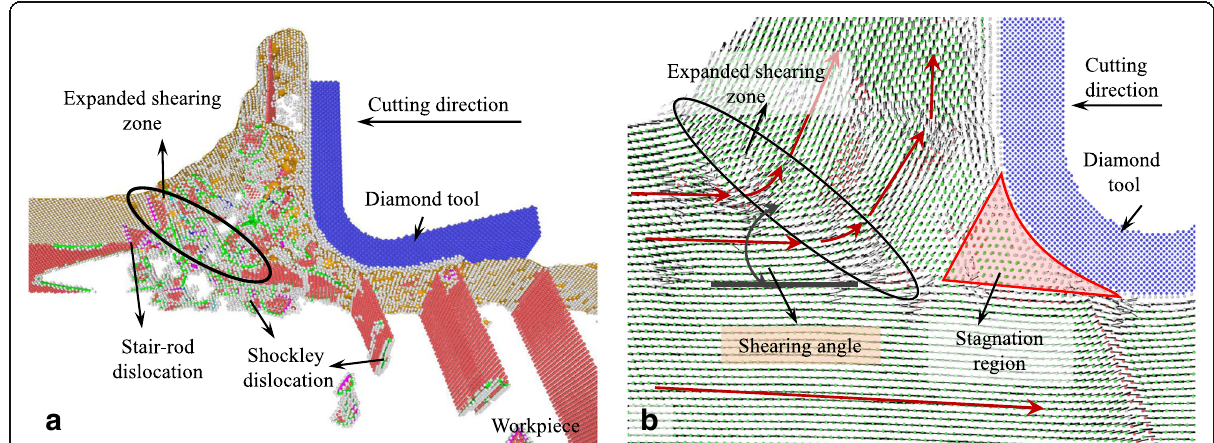
Fig. 8 a Snapshots of the microstructure evolution l at cutting direction of {111}<11-2>, b displacement vector sliced at 4 nm in z